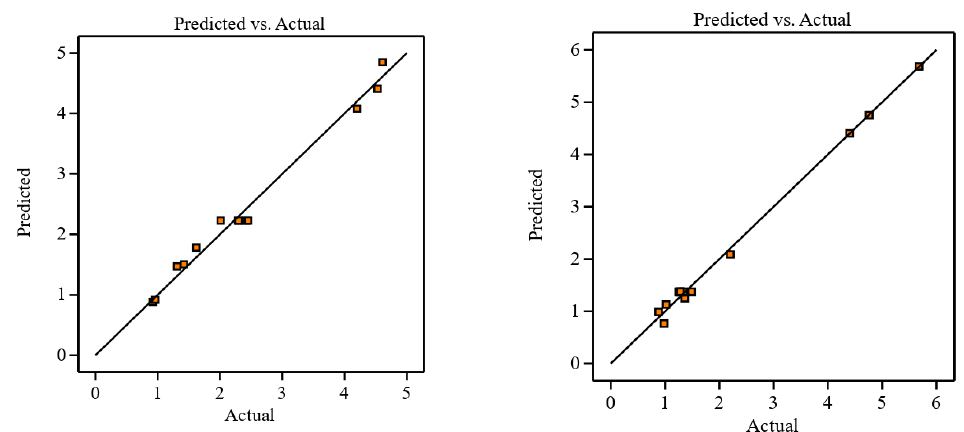
Figure 18. Predicted versus actual plot of residuals in the left for Ti-6Al-4V and in the right for Ti- 6Al-7Nb.